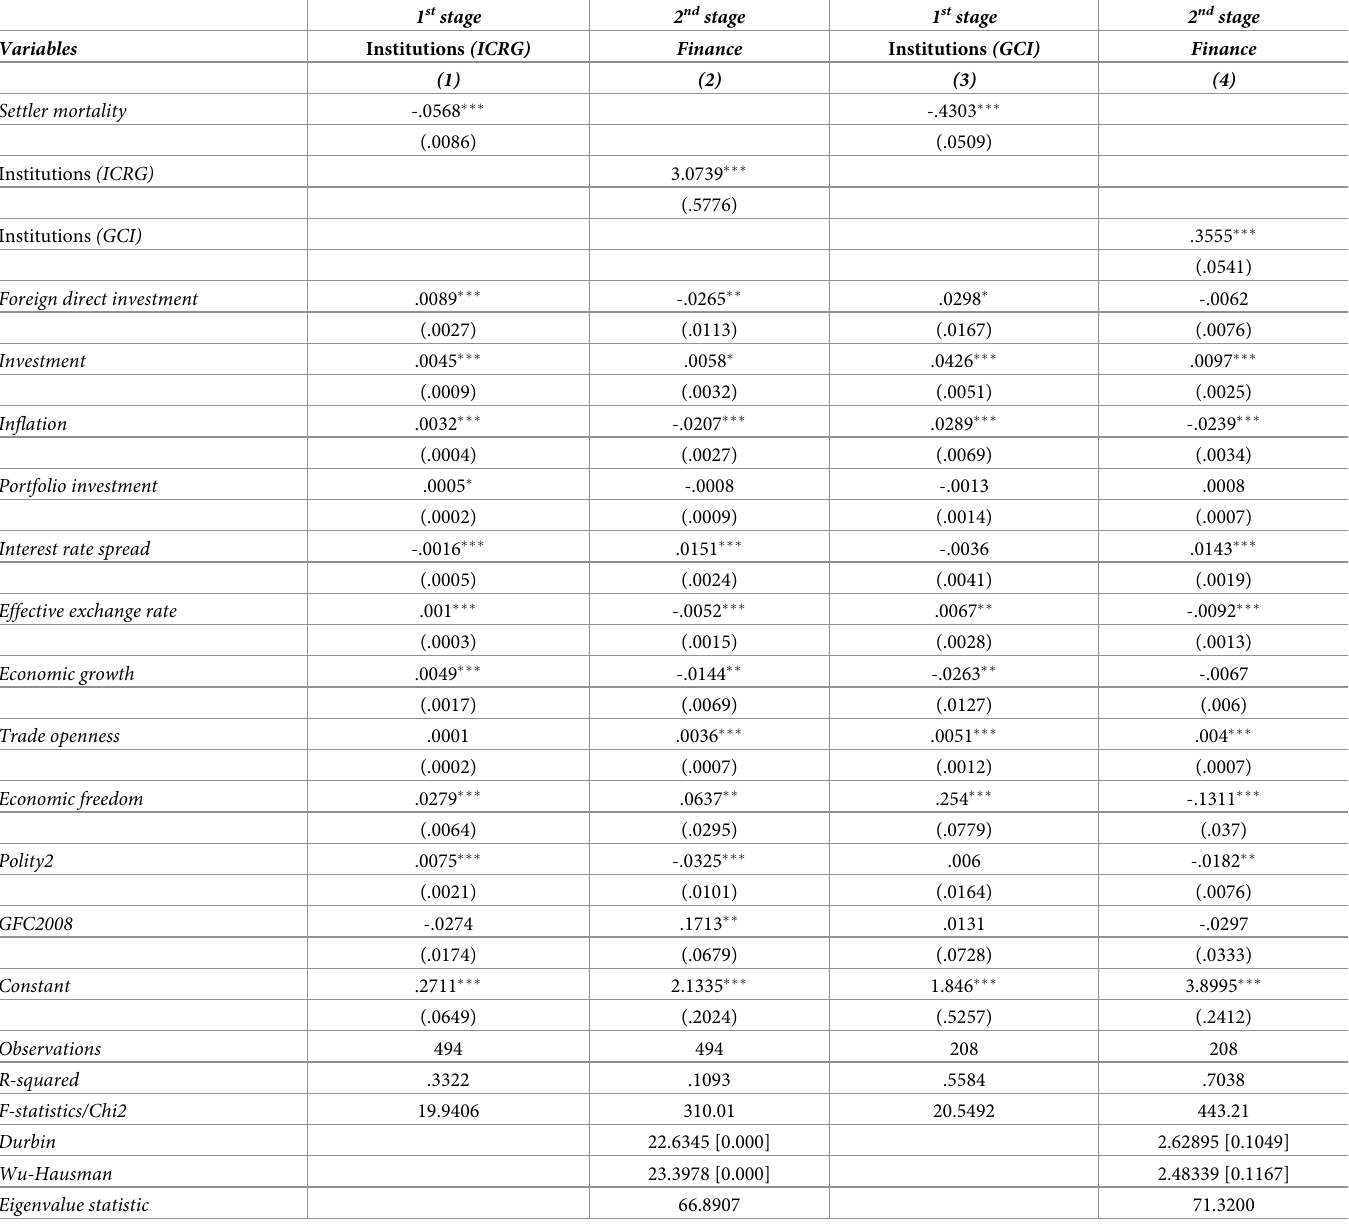
Table 5. Robustness with alternative measures of institutions -2SLS